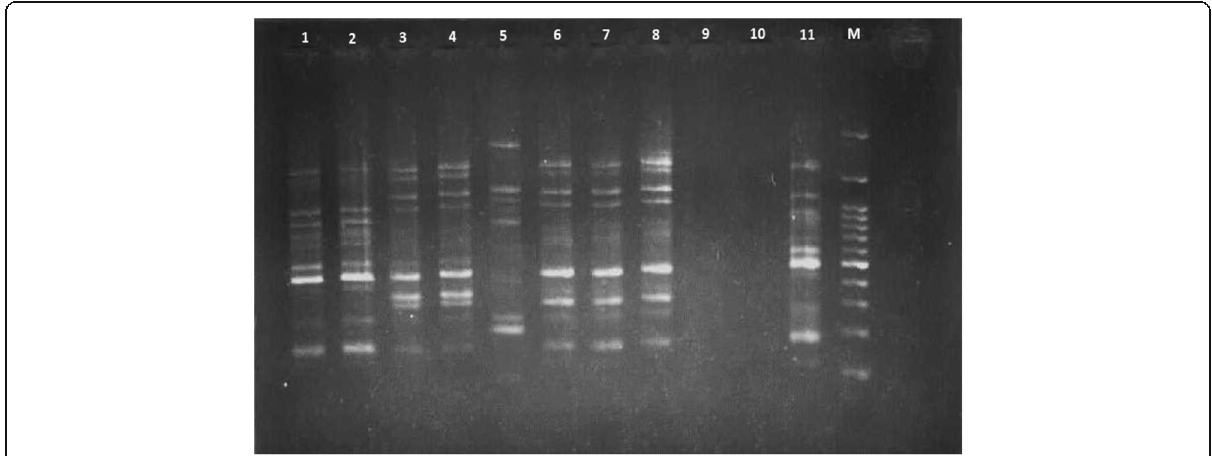
Fig. 2 REP-PCR pattern of some A. baumannii isolates. 1 – 8: A. baumannii isolates, 9 – 10: negative control, 11: positive control ( A. baumannii , ATCC19606), M: 100 bp